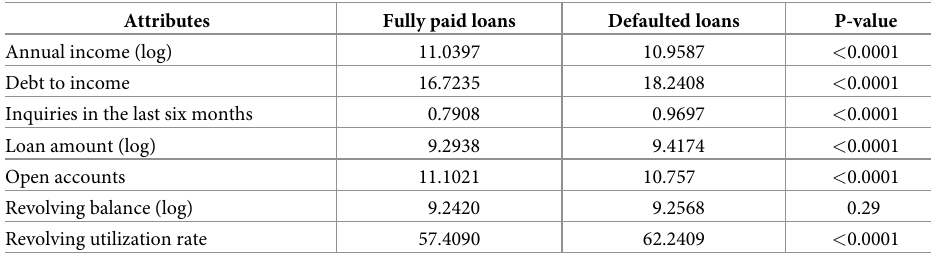
Table 2. Result of the Welch‘s T test for numeric